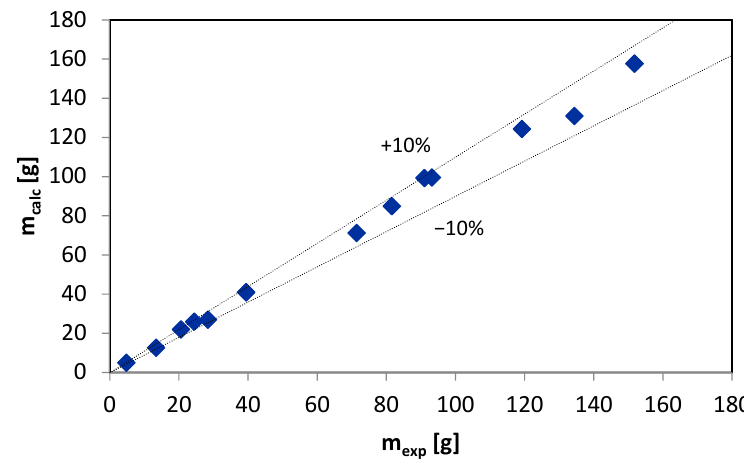
Figure 6. Comparison of measured and predicted by FLMill model mass of the grinding product.